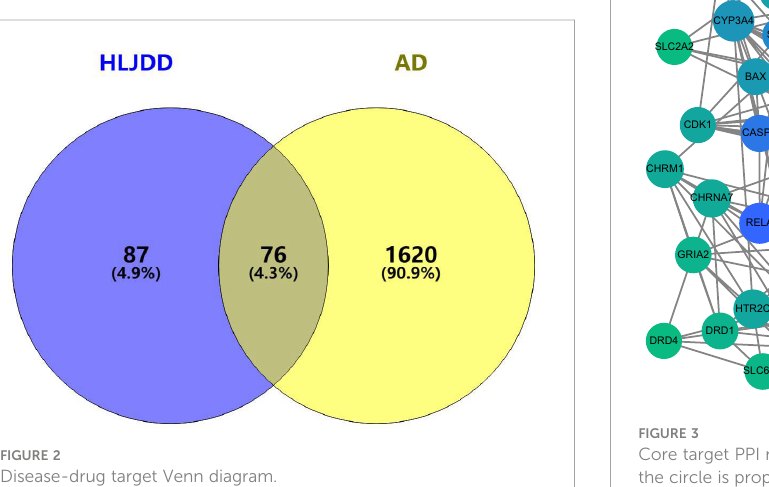
FIGURE 3 Core target PPI network. As shown in the fi gure, the darker color of the circle is proportional to its importance in this